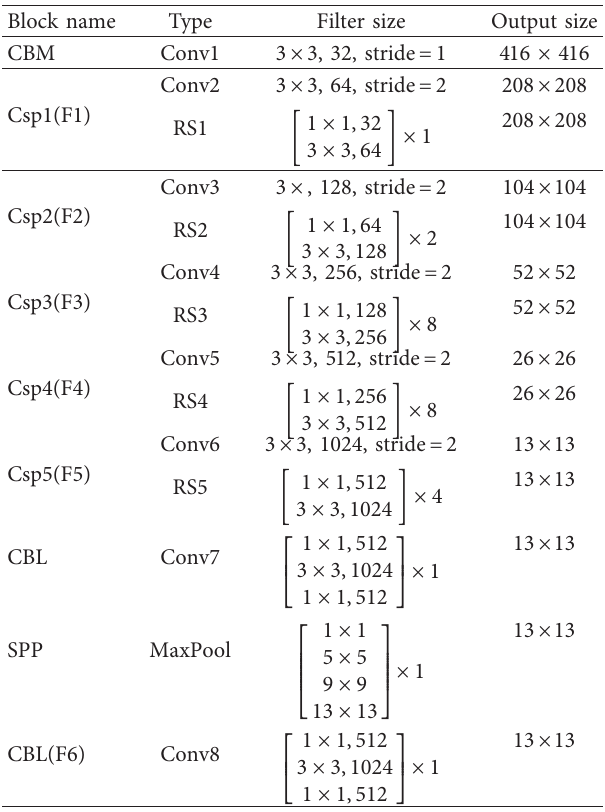
Figure 1: MFF-Yolov4 framework. Table 1: Feature extraction backbone